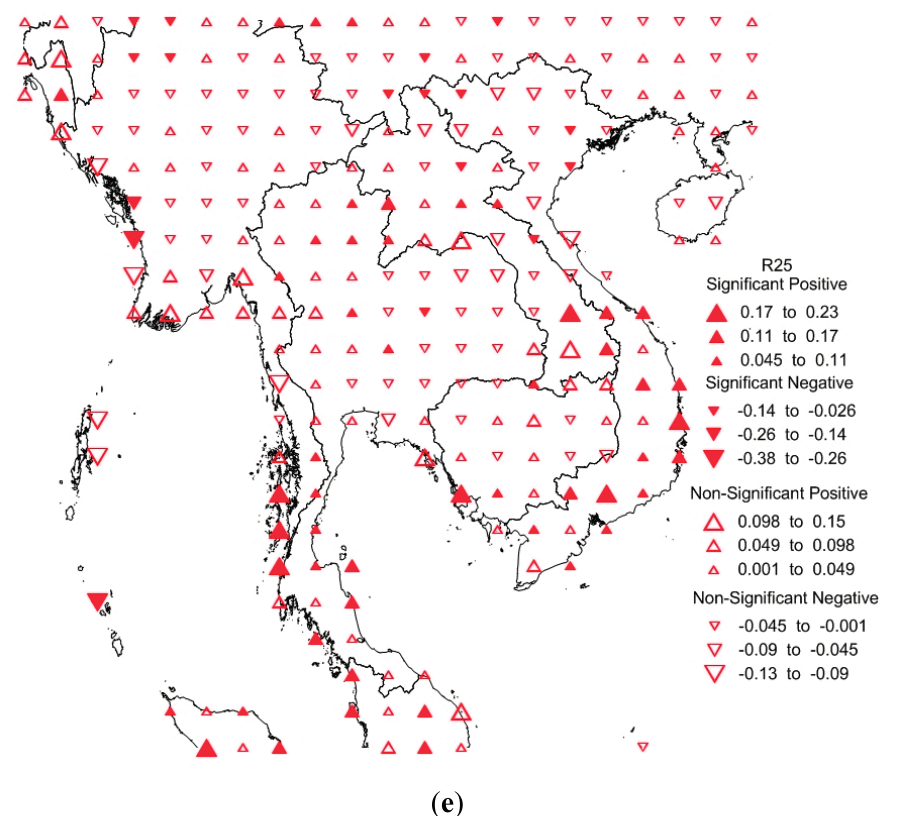
Figure 16. The point pattern analysis of frequency indices of extreme rainfall over the Indochina Peninsula. ( a ) CDD; ( b ) CWD; ( c ) R10mm; ( d ) R20mm; ( e )